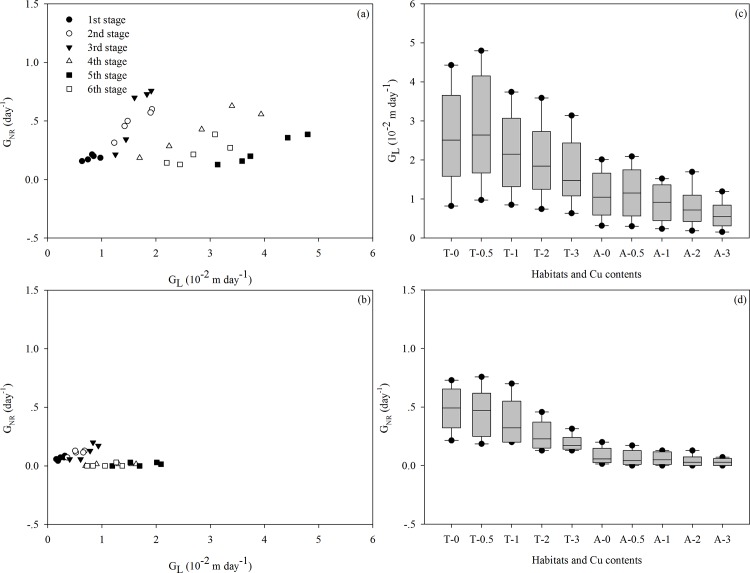
Growth rate of the total length (GL) and growth rate of new ramets (GNR) of Alternanthera philoxeroides in terrestrial habitats (a) and aquatic habitats (b) across six stages. The box-plot graphs show the variation in GL (c) and GNB (d) of the plants in terrestrial habitats (T) and aquatic habitats (A) under different Cu pollution, and the data for the stages are grouped together.